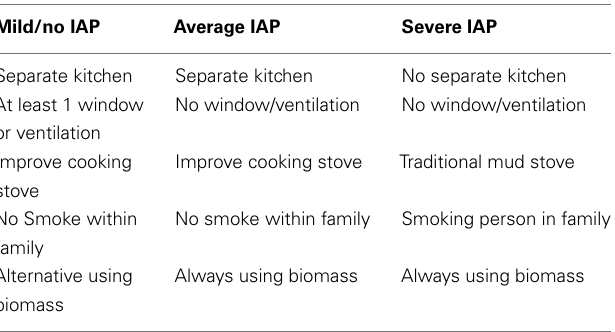
Table 2 | Degree of air pollution fromTable 1 .